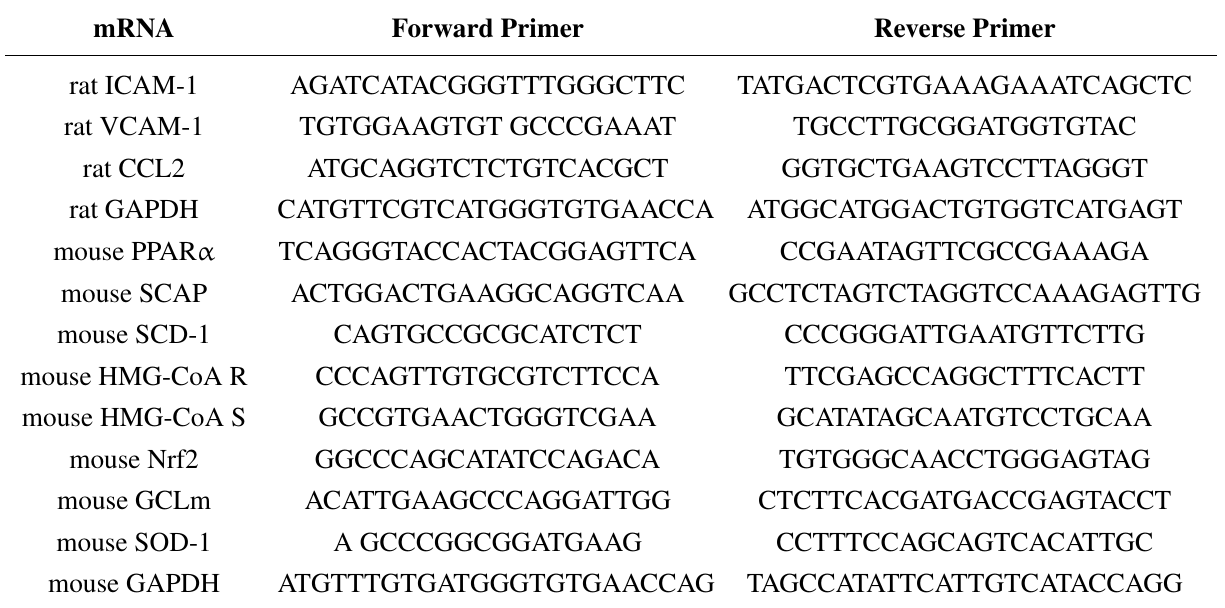
Table 1. Primer sequences (from 5 1 to 3 1 ) for measuring mRNAs using real-time